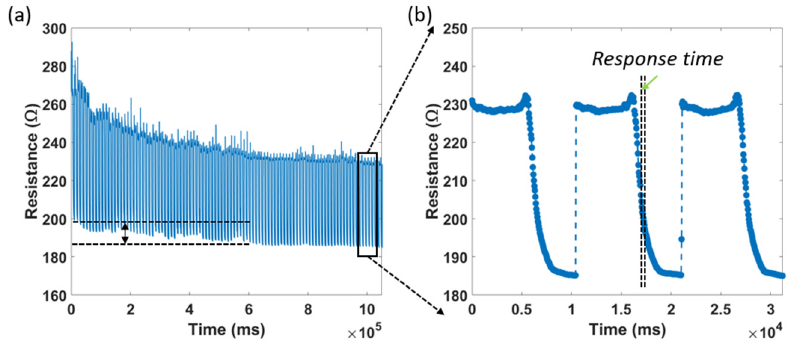
Figure 5. ( a ) Resistance change in 100 loading / unloading cycles and ( b ) Response time.